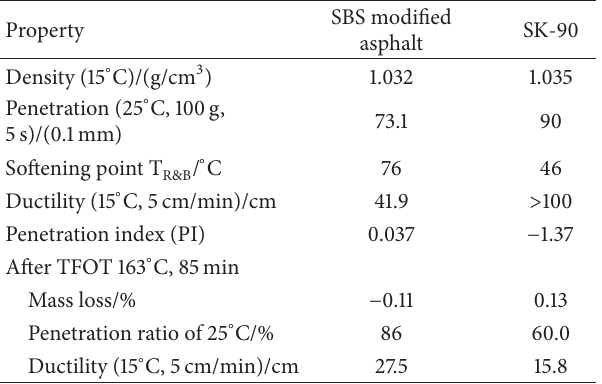
Table 1: Physical properties of base asphalt and modified asphalt.